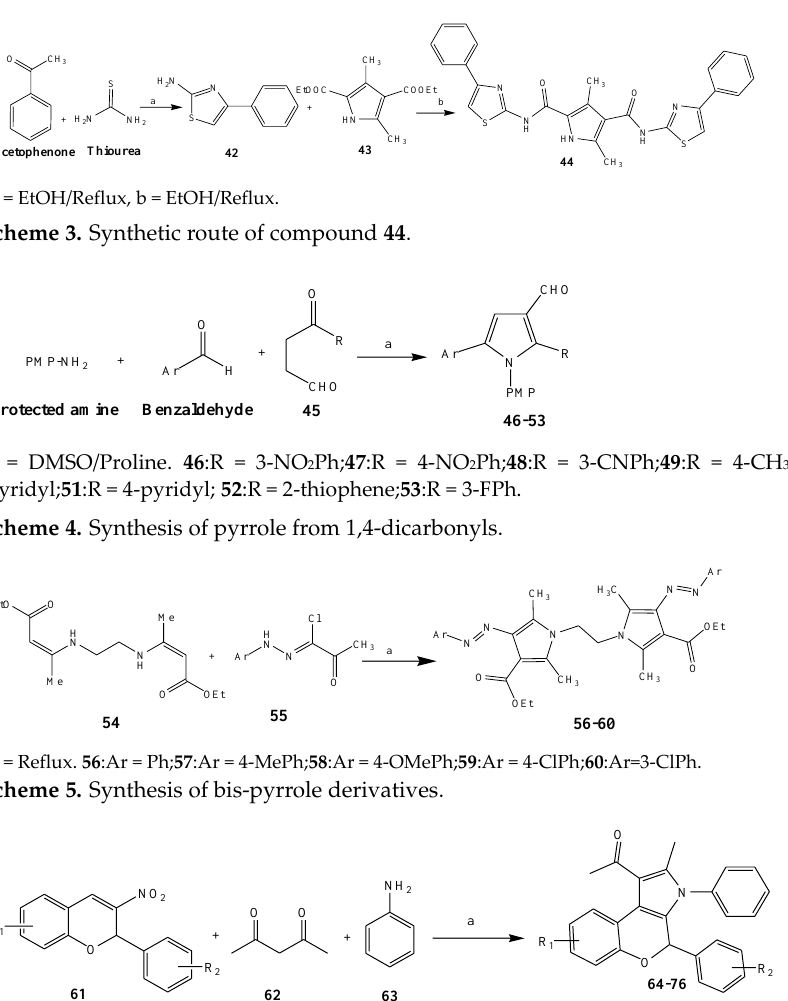
Scheme 2. Synthetic route for the synthesis of pyrrole[3,4-b]quinolin-2(3 H )-yl)bezamide derivatives ( 37 – 41 ).